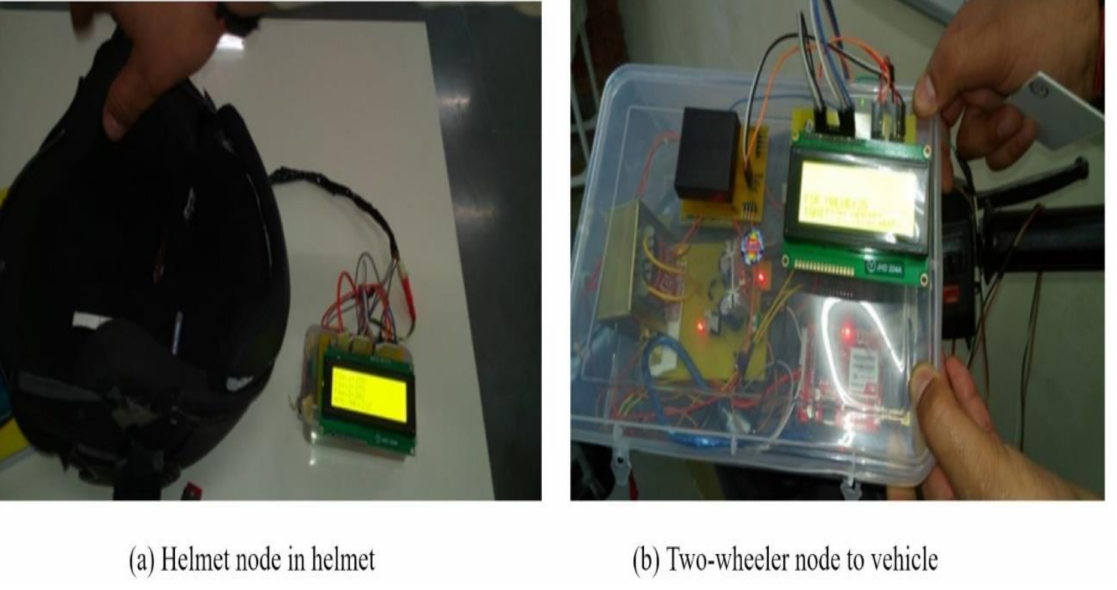
Figure 14. The helmet node and two-wheeler node.